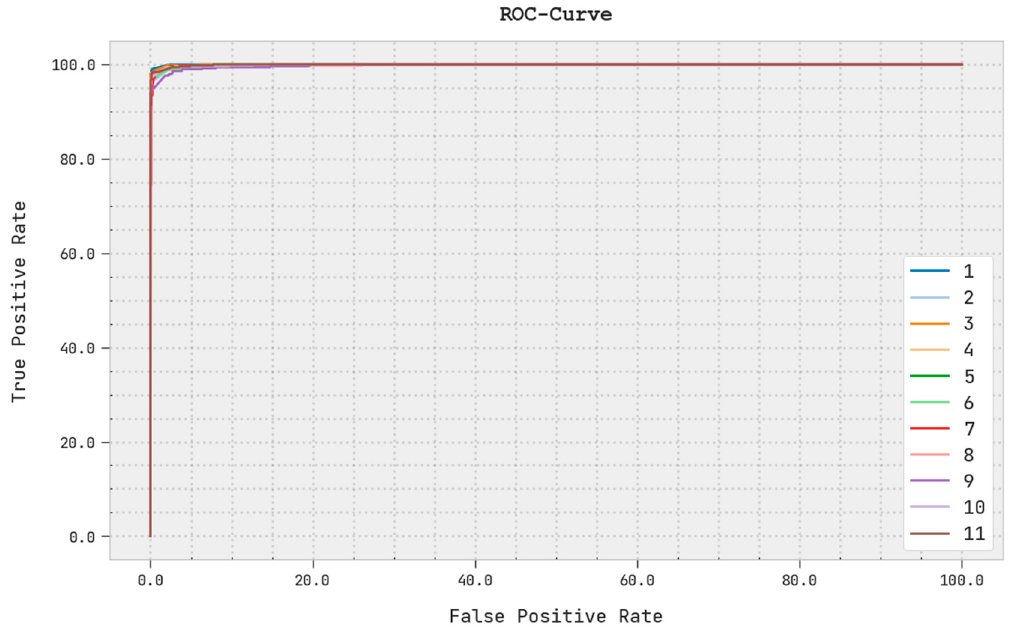
Figure 9. ROC analysis of PODCNN-LWID approach.